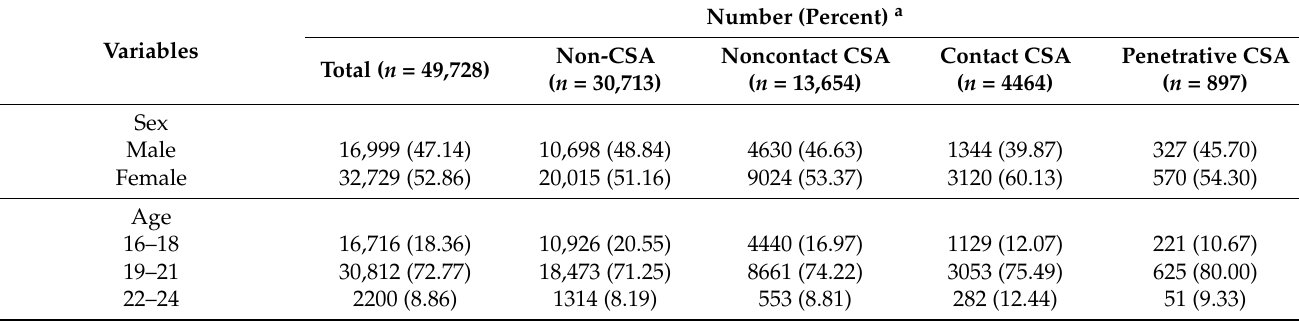
Table 2. Characteristics of respondents without and with a history of different types of CSA ( n =